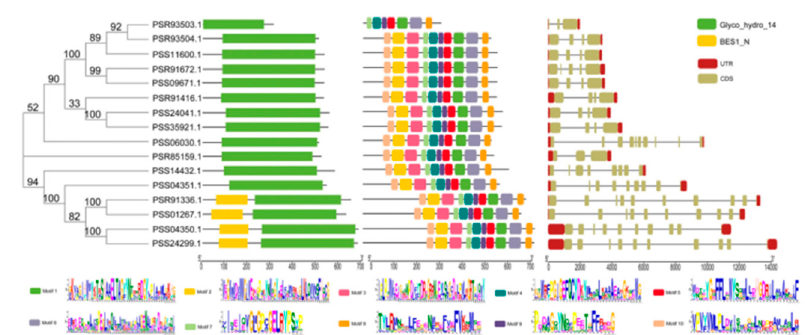
Figure 4. Consensus phylogenetic tree of BAM genes in A. chinensis constructed by amino acid multiple sequence alignment using MEGA-X software. Schematic representations of the conservative domain of AcBAM genes. Schematic representations of conservative motifs of AcBAM genes. Different motifs are highlighted with different colored boxes with numbers 1 to 20. Lines represent protein regions without detected motifs. Exons are represented by boxes. Dashed line connecting two exons represents an intron.